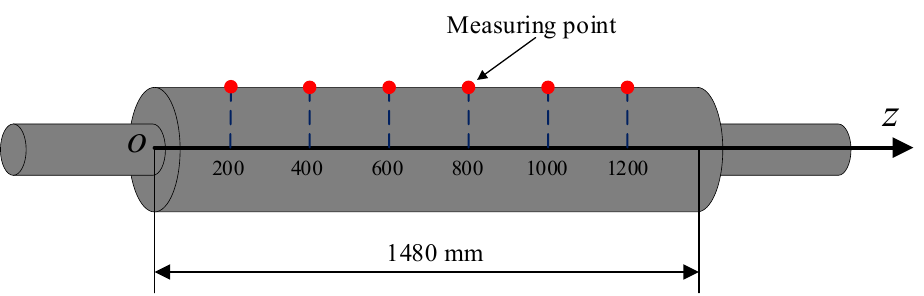
z o The grinding wheel grinds from the left side of the shaft to the right side in a grinding pass. On the next grinding pass, the grinding wheel grinds from the right side of the shaft to the left side. In order to expand the number of samples, six measuring points are se ‐ 1480 mm lected along the z ‐ direction on the shaft after grinding to test the surface roughness and glossiness as shown in Figure 3. The measuring points in this study are distributed uni ‐ Figure 3. Measuring points of shaft. formly along the length of the shaft, which can reflect the trend of surface quality on the Figure 3. Measuring points of whole shaft.